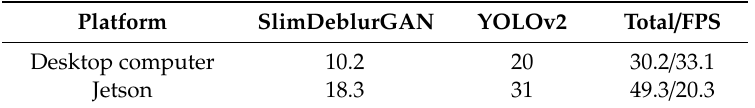
Table 17. Total processing time (ms) per image by our method on two platforms.